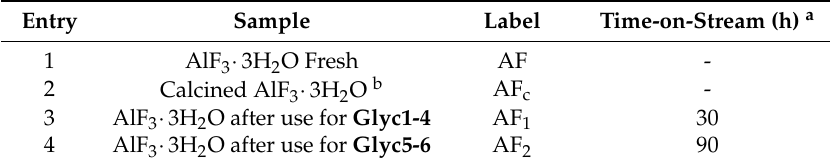
Table 4. Different samples of fresh, calcined, and used AlF 3 ·3H 2 O considered for characterization analyses.